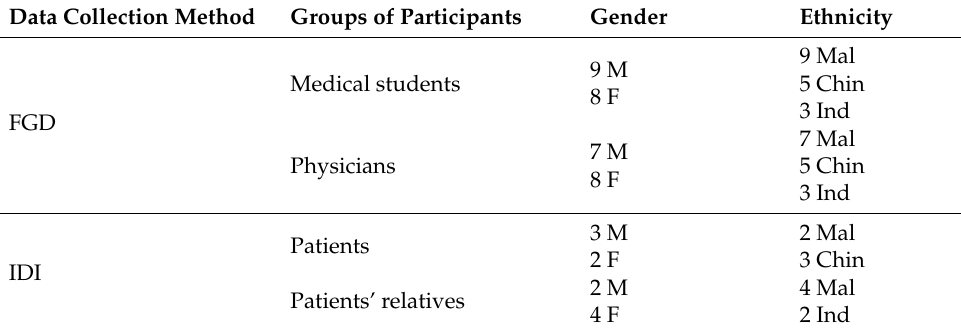
Table 1. Demographic details of the participants. Data Collection